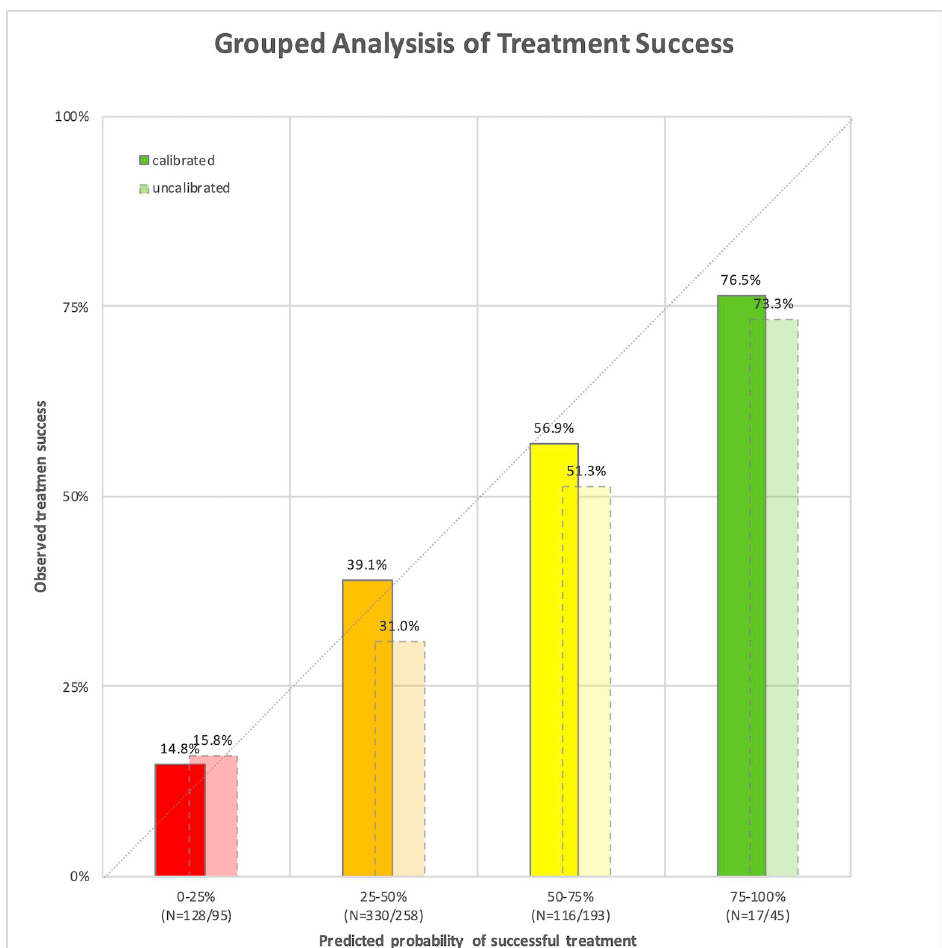
Fig 4. Correlation of the observed success rate to the predicted probability of success from the multivariable prediction models (original, calibrated and recalculated). The individual probability of ocriplasmin treatment success was calculated for every patient. Patients were grouped by their calculated success probability (grouped in 25% intervals; red: intravitreal ocriplasmin (IVO) success group: 0% to 25%, orange: 25% to 50%, yellow: 50% to 75%, and green: 75% to 100%). The calculation was performed with the calibrated model (dark colors, continuous border) and uncalibrated EXPORT (light colors, broken border) models. Number (n) of patients per interval in both models is given at the